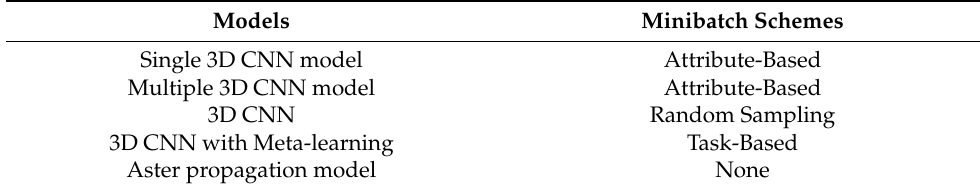
Table 5. Comparison of the proposed work with previous related